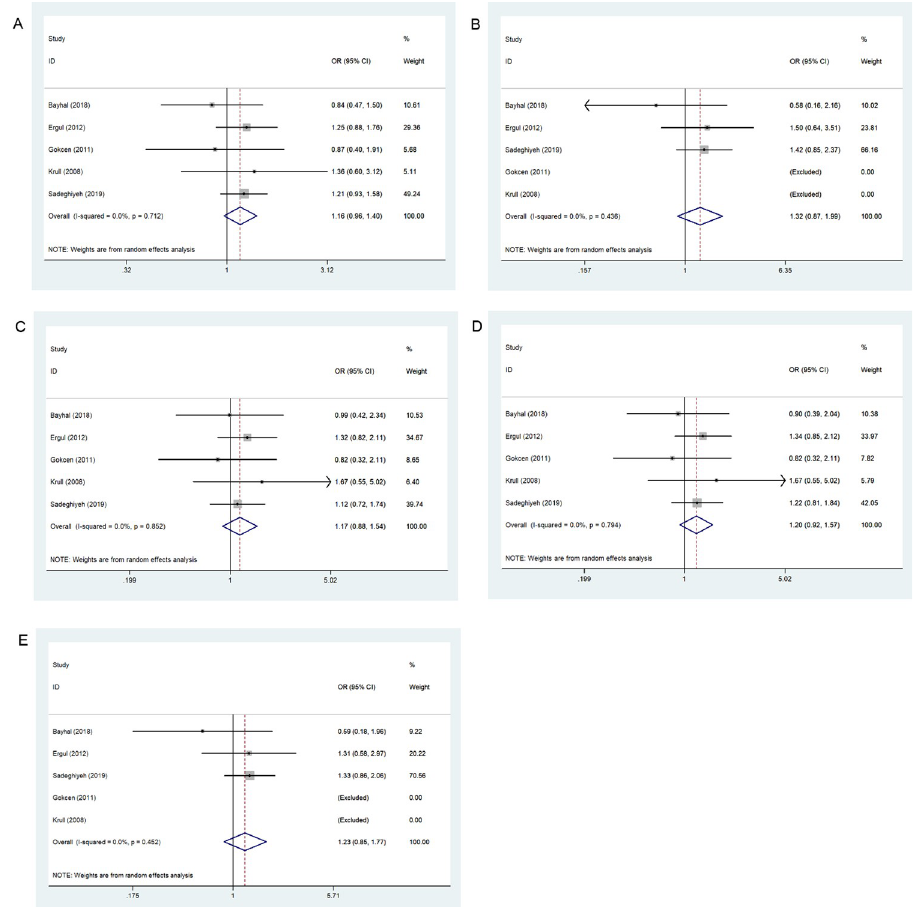
Fig 2. Forest plot of the association between 667C > T variation and risk of ADHD in the five genetic models: A, allele contrast; B, homozygous codominant; C, heterozygous codominant; D, dominant; and E, recessive.